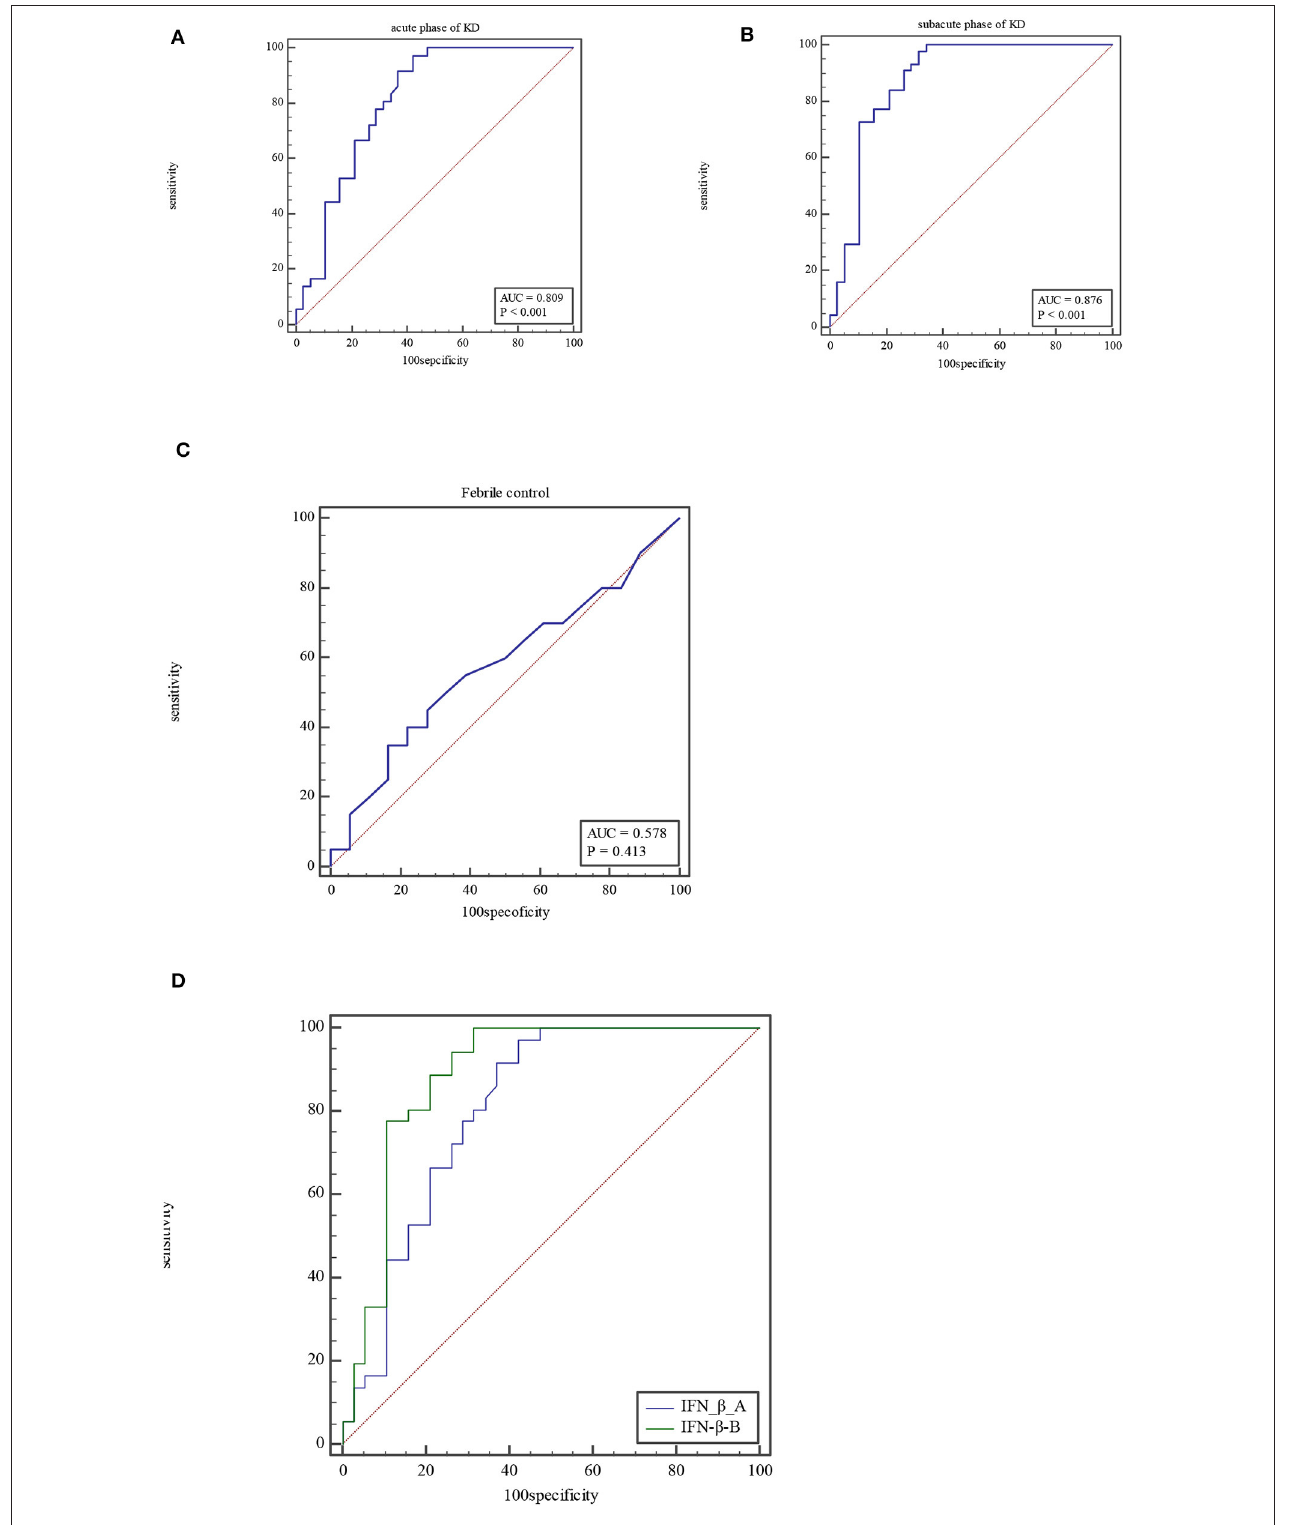
FIGURE 1 | ROC curve of IFN- β at acute phase of KD (A) , subacute phase of KD (B) , and febrile control corhort (C) . Comparison of ROC for IFN- β between at acute phase of KD and subacute phase (D) .